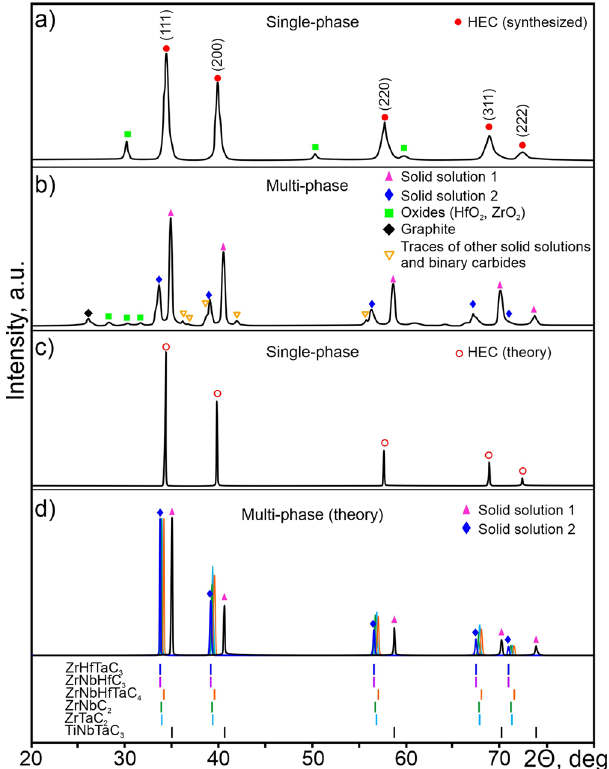
Fig. 3 Comparison of X-ray diffraction patterns of synthesized and simulated carbides. X-ray diffraction patterns of the synthe- sized a single- and b multi-phase samples of TiZrNbHfTaC 5 , and calculated XRD patterns of c simulated single-phase HEC, and d separate phases of ZrHfTaC 3 , ZrNbHfC 3 , ZrNbHfTaC 4 , ZrNbC 2 , ZrTaC 2 , and TiNbTaC 3 found by the analysis of calculated Gibbs free energies of mixing of various multi-component